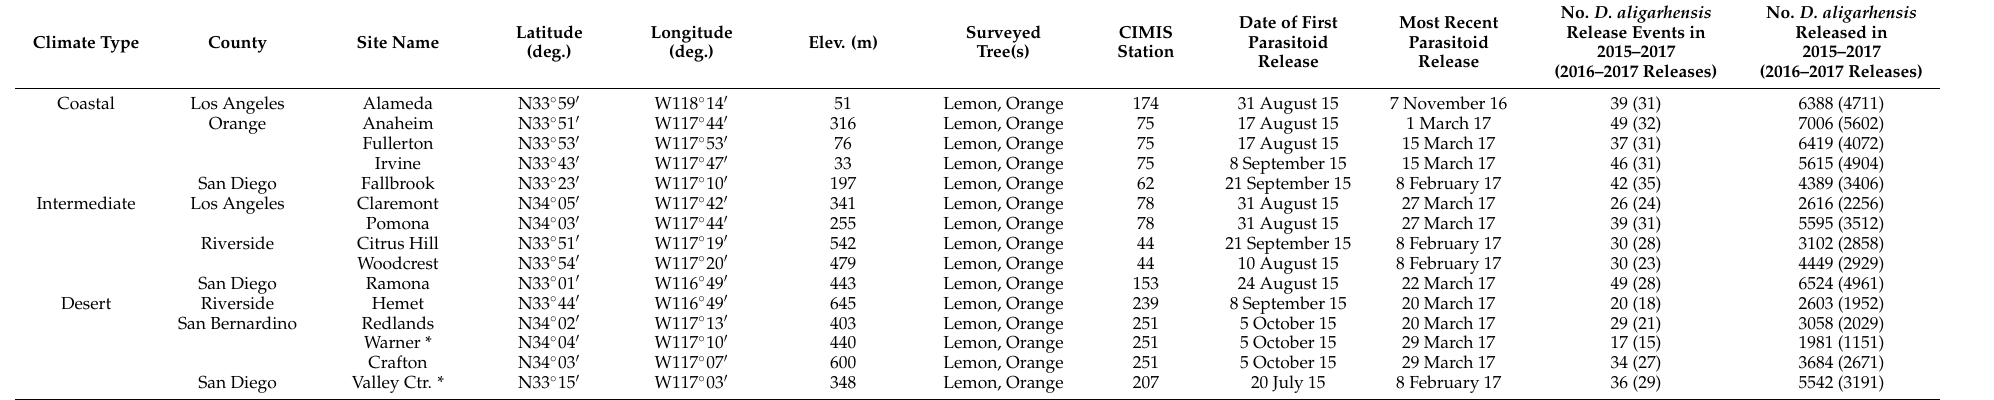
Table 1. Site characteristics and parasitoid release frequencies and numbers for selected D. aligarhensis release sites in southern California,